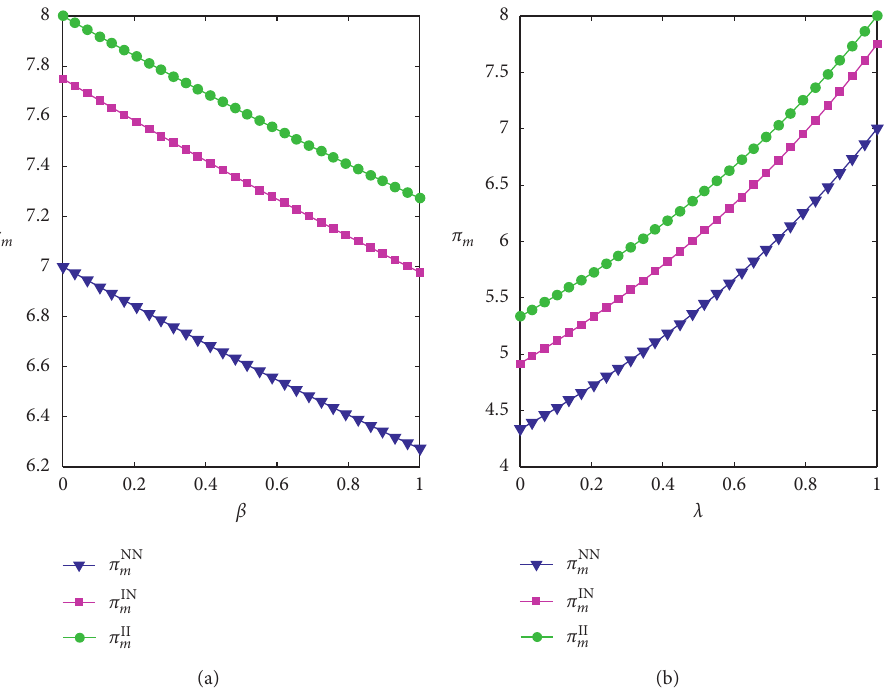
Figure 7: Comparisons on the manufacturer’s profit among three models. (a) The manufacturer’s profits with respect to β . (b) The manufacturer’s profits with respect to λ . Note: (a) v � 10, t � 2, and λ � 0 . 9; (b) v � 10, t � 2, and β � 0 . 5.